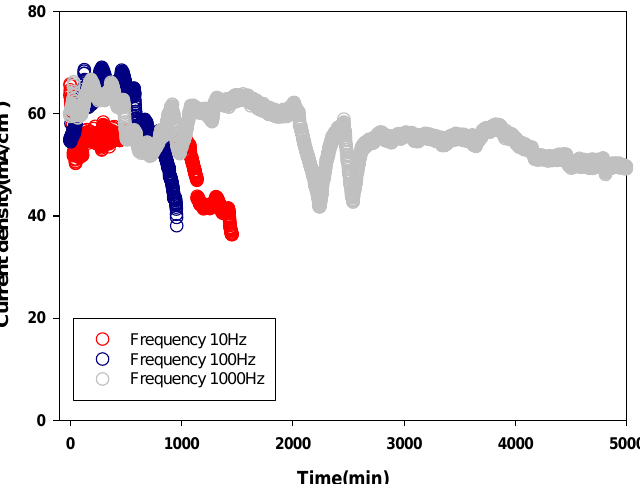
Figure 9. The 5000 min cell performance operation test using DMFCs based on the Au coated PCB substrates using a pulse electroplating method with various frequencies.